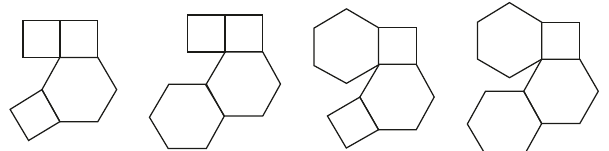
; (b) Kinks of type T 2 , 1